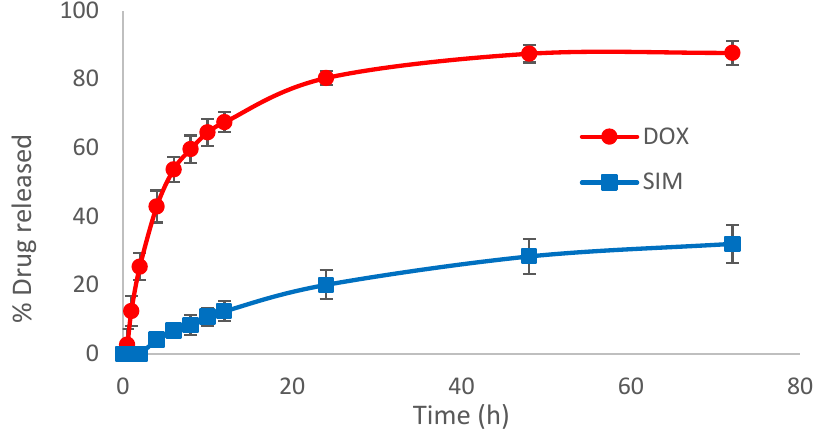
Figure 6. In vitro drug release profile of the optimal formulation. The concentration of the active substances in the release media were determined using the HPLC method.